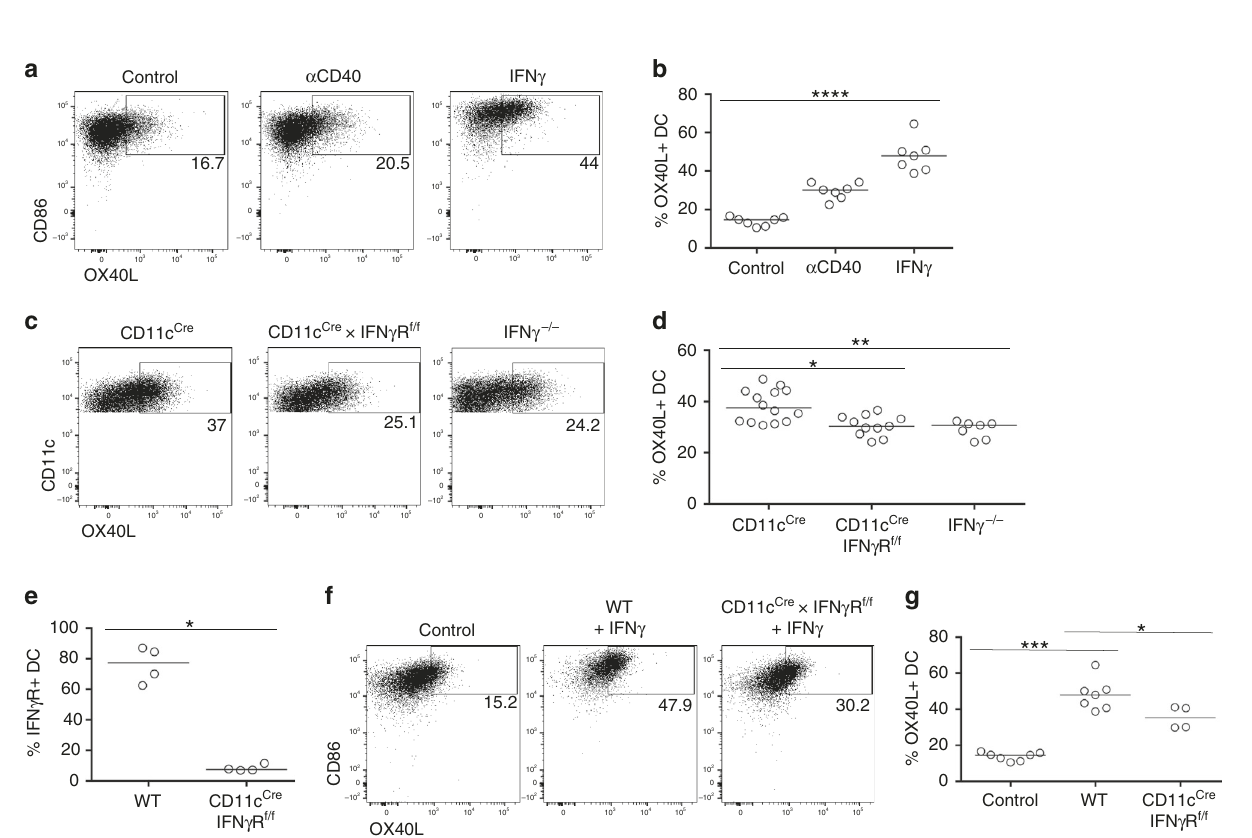
Fig. 5 IFN γ directly enhances OX40L expression on DCs. To determine the mechanism of how IFN γ caused the upregulation of OX40L on DCs, in vitro and in vivo experiments to test a direct interaction were performed. a Representative fl ow cytometric plots showing the expression of OX40L by splenic DCs cultured with either anti-CD40 Abs or recombinant IFN γ . b Percentage of DC-expressing OX40L after culture. Data were pooled from 2 independent experiments, n = 7. c Representative fl ow cytometric plots showing the expression of OX40L on DCs from CD11c Cre , CD11c Cre × IFN γ R f/f and IFN γ − / − mice 24 h after infection with Lm -2W1S. d Proportion of DC-expressing OX40L 24 h post infection with Lm -2W1S. Data are representative of 3 independent experiments ( n = 14 CD11c Cre mice, n = 11 CD11c Cre × IFN γ R f/f mice, n = 7 IFN γ − / − mice). e Proportion of DC-expressing IFN γ R in WT versus CD11c Cre × IFN γ R f/f mice. Data are representative of 2 independent experiments ( n = 4 mice per group). f Representative fl ow cytometric plots showing the expression of OX40L by DCs isolated from WT versus CD11c Cre × IFN γ R f/f mice and cultured with recombinant IFN γ . g Proportion of DC-expressing OX40L after culture with recombinant IFN γ . Data are representative of 2 independent experiments ( n = 7 WT mice, n = 4 CD11c Cre × IFN γ R f/f mice). Values on fl ow cytometric plots represent percentages; bars on scatter plots represents the median. Statistical signi fi cance was tested in b , d by using Kruskal – Wallis one-way ANOVA with post hoc Dunn ’ s test and in e , g by using an unpaired, non-parametric, Mann – Whitney two-tailed T test: * p ≤